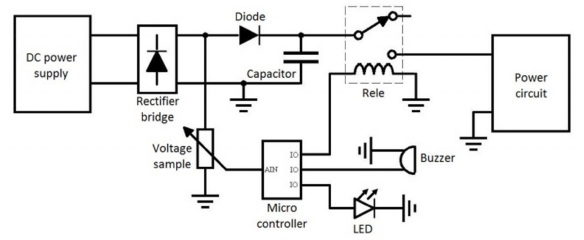
Figure 11. Schematic diagram of the protection circuit of the power